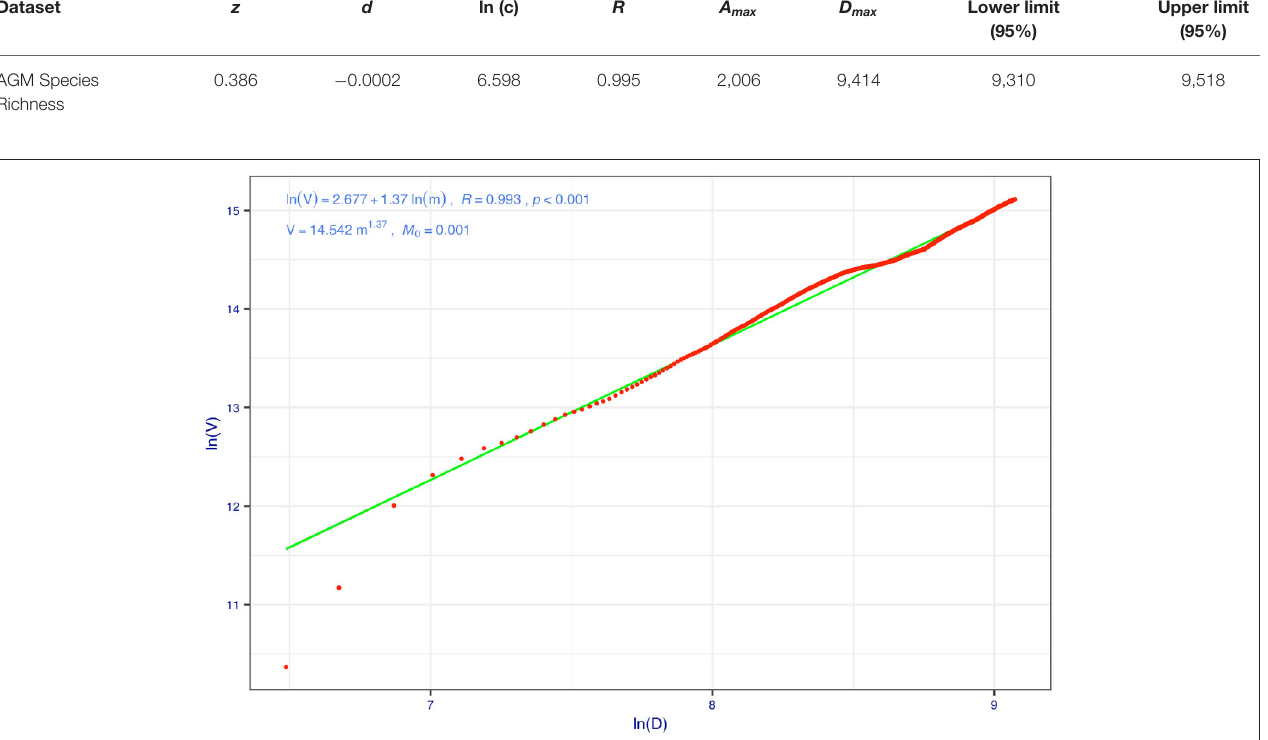
FIGURE 4 | Taylor’s power law (TPL) model for the cumulative species richness of American gut microbiome (AGM) data set (the 100 times of re-sampling were used to fit 100 PL models, and here is one example): for each time of re-sampling, there are 1,473 pairs of variance/mean of species richness, computed for each step of diversity-area relationship (DAR)